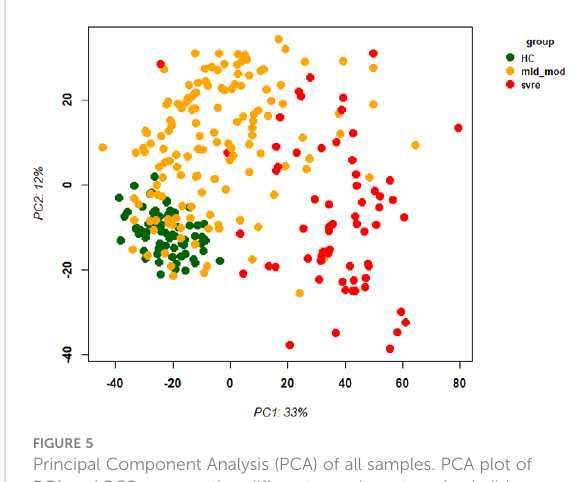
FIGURE 5 Principal Component Analysis (PCA) of all samples. PCA plot of PC1 and PC2 representing different severity categories (mild, moderate, severe, and healthy) by colors. Abbreviations: HC stands for healthy controls; mld_mod stands for mild and moderate; svre stands for severe.